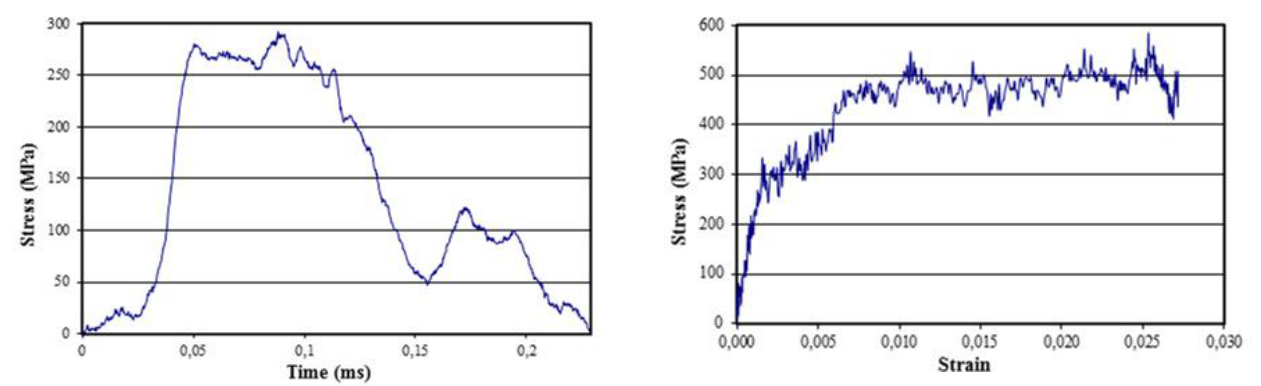
Figure 17. Stress-strain curve relating to the modified SHTB with- out the interruption fixture (Model 2) at a pressure equal to 3.5bar.